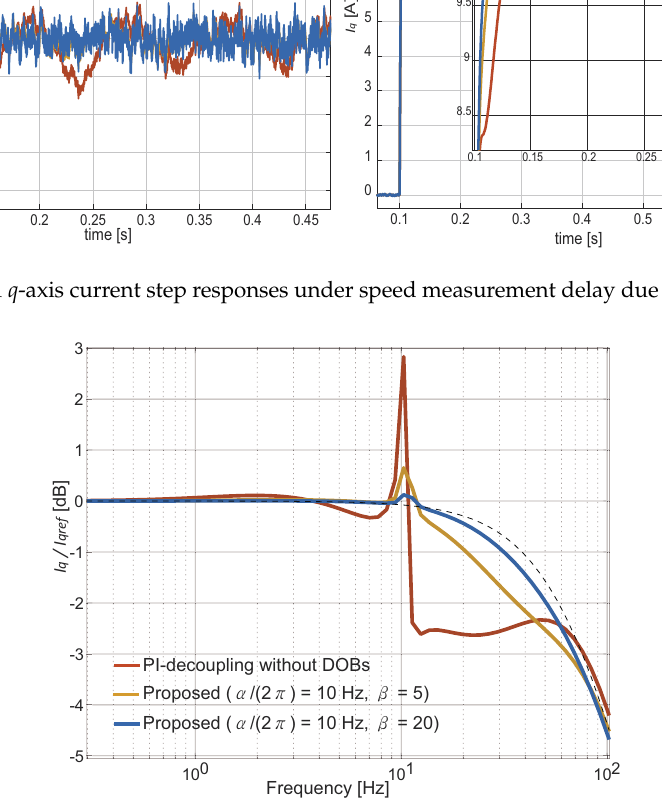
Figure 10. The d - and q -axis current frequency responses under speed measurement delay due to the low-pass